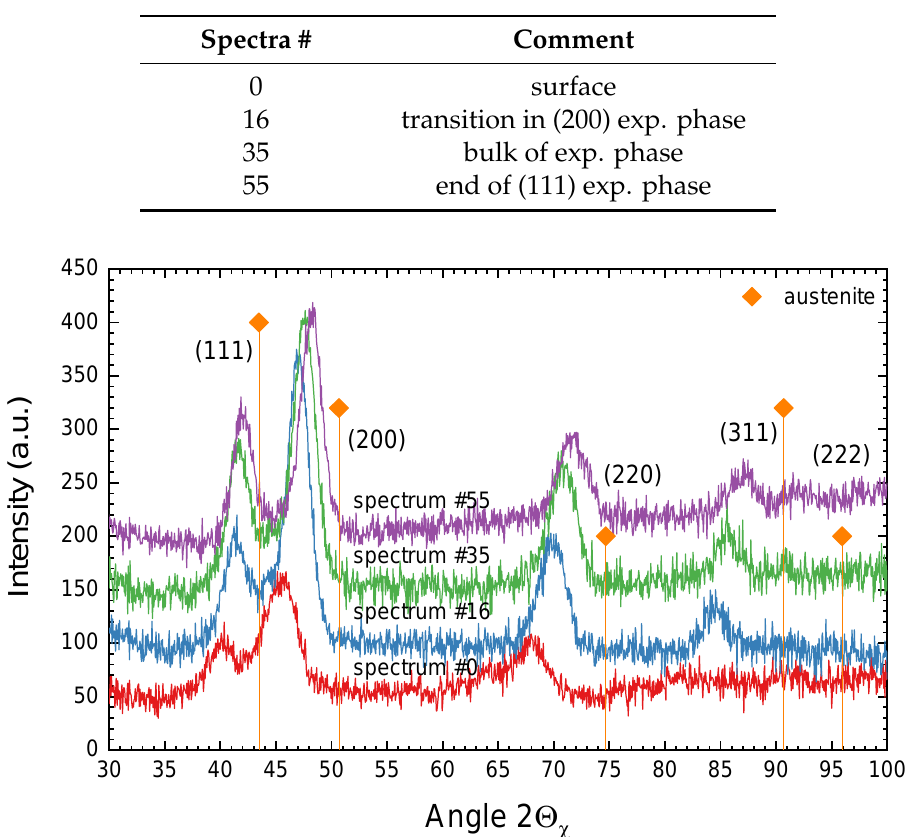
Table 1. List of positions where extensive ex situ XRD investigations were performed.